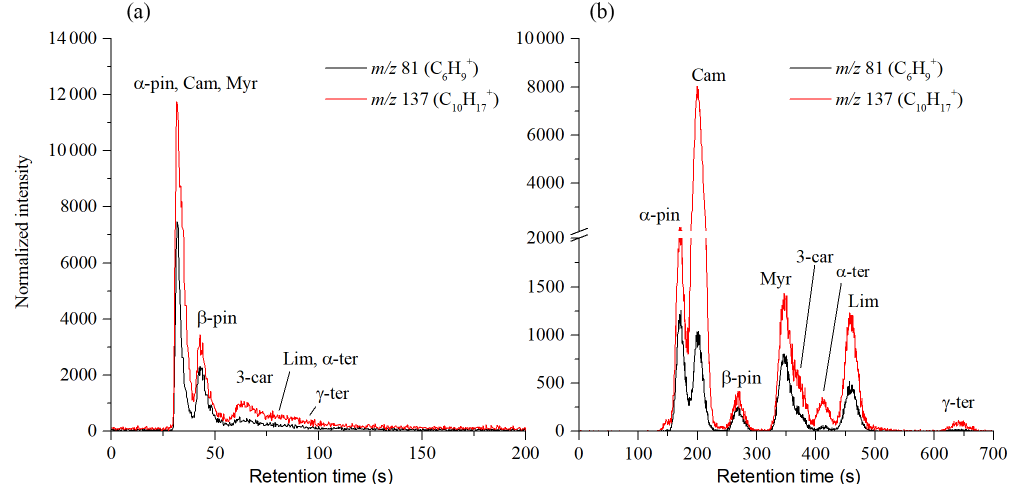
Figure 3. Chromatograms of mixtures of monoterpenes at room temperature obtained using the MXT-1 column (a) and the MXT-Volatiles column (b) . Chromatogram peaks in the MXT-1 column are not fully separated, but separation takes less than 150s compared to the 700s required for the MXT-Volatiles column. The signal intensities are the analyte ion count rates normalized to a H 3 O + reagent ion count rate of 10 6 s − 1